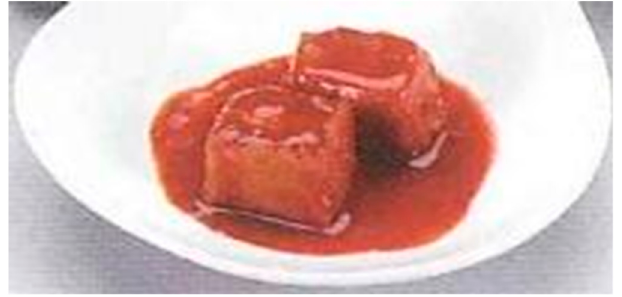
Figure 4. Tofuyo , a food that has been passed down the generations in Okinawa, Japan.